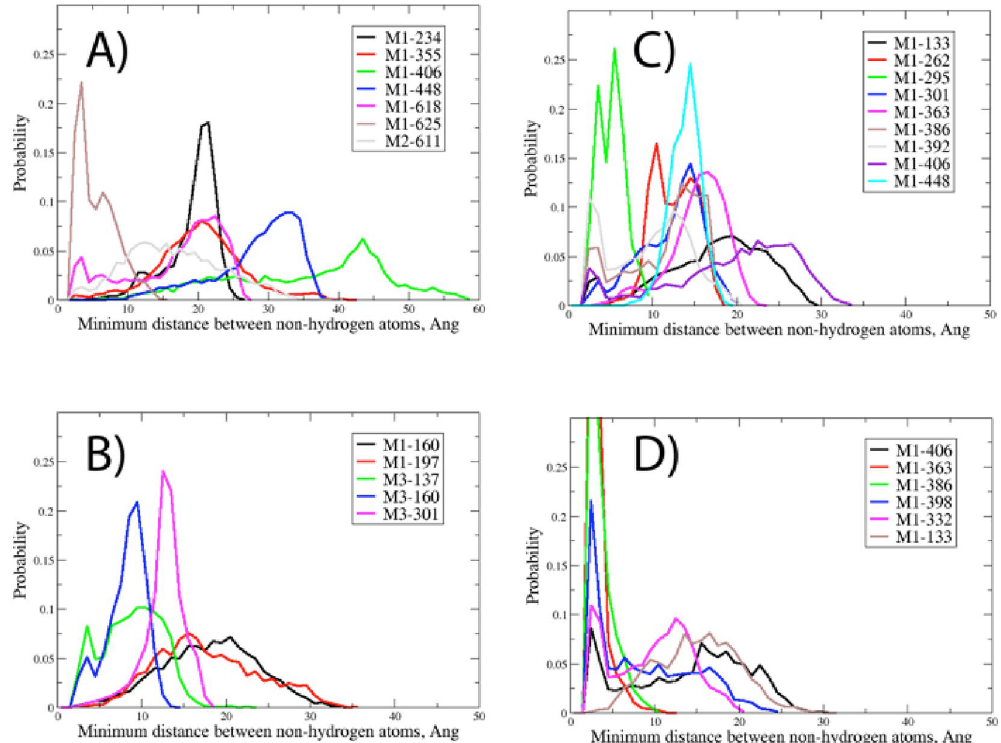
Figure 4. Probability distribution of the minimum distance of all glycans that come within 5 Å or less with the selected glycan for ( A ) M1-g88, ( B ) M3-g156, ( C ) M1-g332 and ( D )